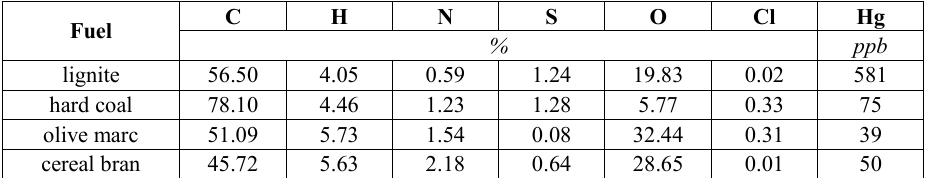
Table 1. Results of elemental analysis of the selected solid fuels (dry state) Fuel